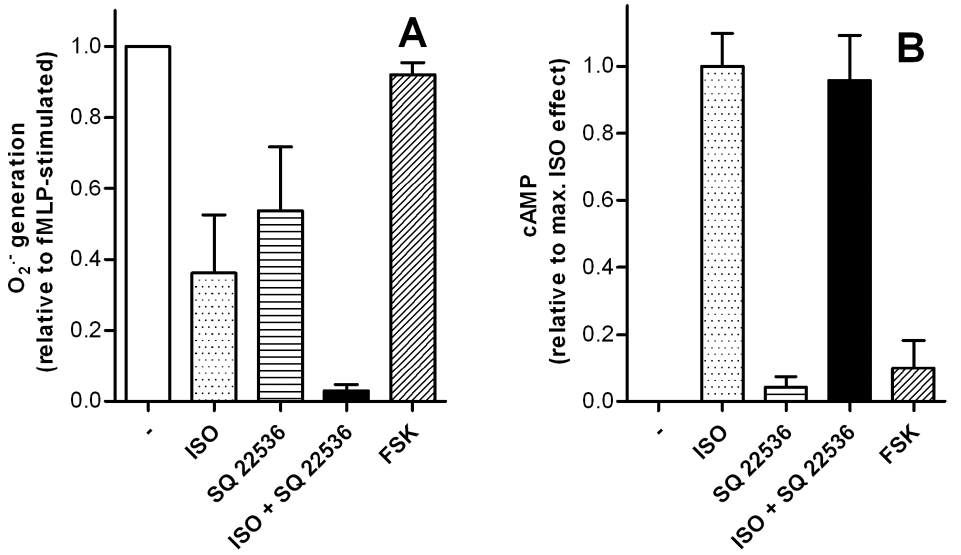
Figure 8. Effects of SQ 22536 and FSK on the fMLP-stimulated O 2 N 2 production (A) and cAMP accumulation (B). The O 2 N 2 assay (1 6 10 5 cells per well) and the cAMP assay (5 6 10 5 cells per cup) were performed as described in Materials and Methods. Data shown (mean 6 S.E.M.) are from three to six independent experiments, performed in triplicate. Concentrations used are as follows; ISO 100 nM ( A ) and 1 m M ( B ), SQ 22536 100 m M. For comparison, we also studied the effect of the direct AC activator FSK (10 m M). In all tubes, a final concentration of 1% (v/v) DMSO (unavoidable for dissolving SQ 22536 and FSK) was present to achieve comparable results. SQ 22536 had no significant reversal effect on the inhibition caused by ISO in the